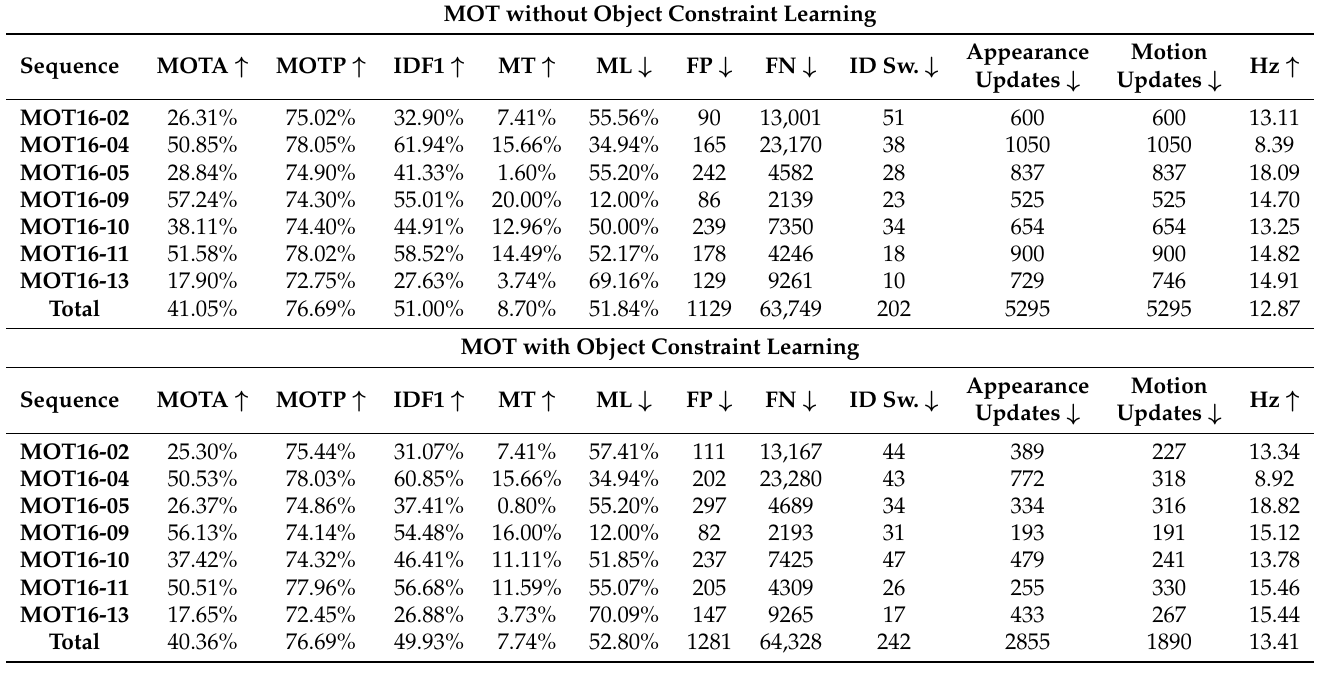
Table 6. The MOT performance comparison between multi-object tracking methods with/without the proposed object constraint